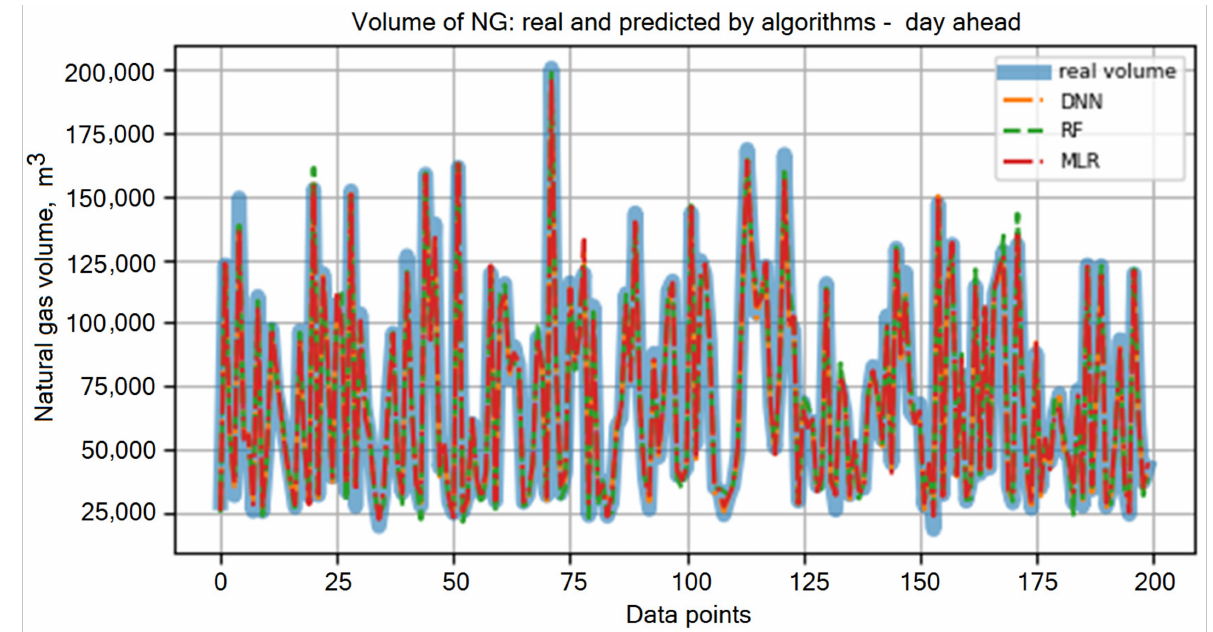
Figure 11. Real and predicted total natural gas demand (day ahead).